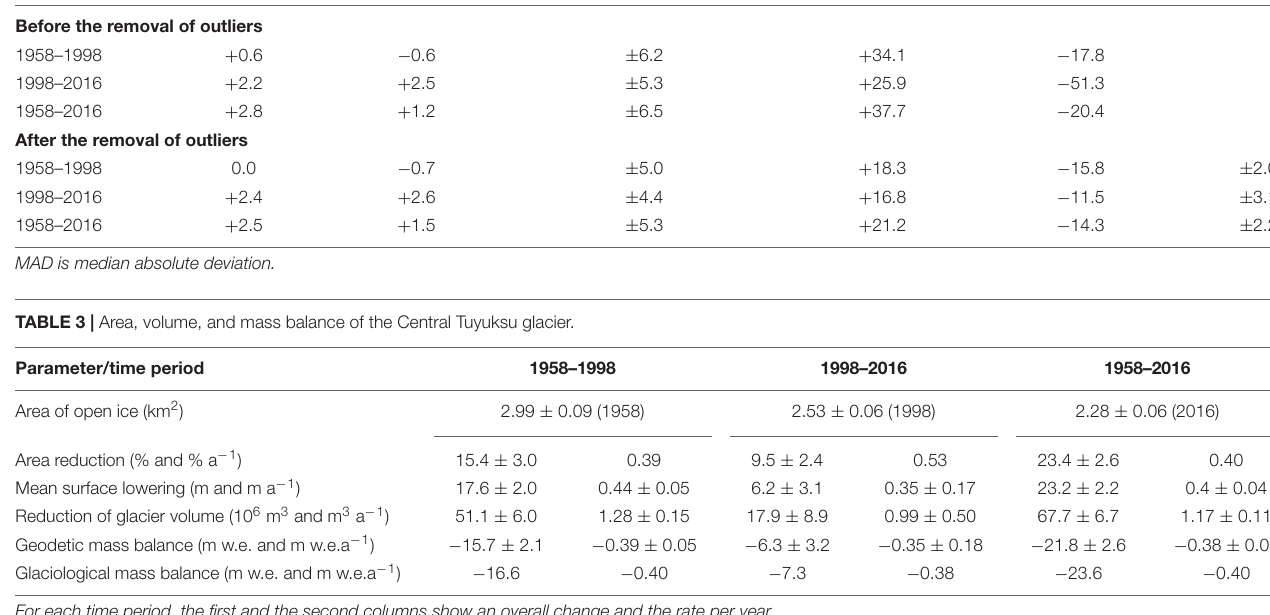
TABLE 2 | Digital elevation model (DEM) bias statistics (m) calculated for the areas of stable, ice-free terrain and slope less than 30 ◦ following an adjustment between DEM and ground-control points. Period Mean Median Standard deviation Maximum Minimum